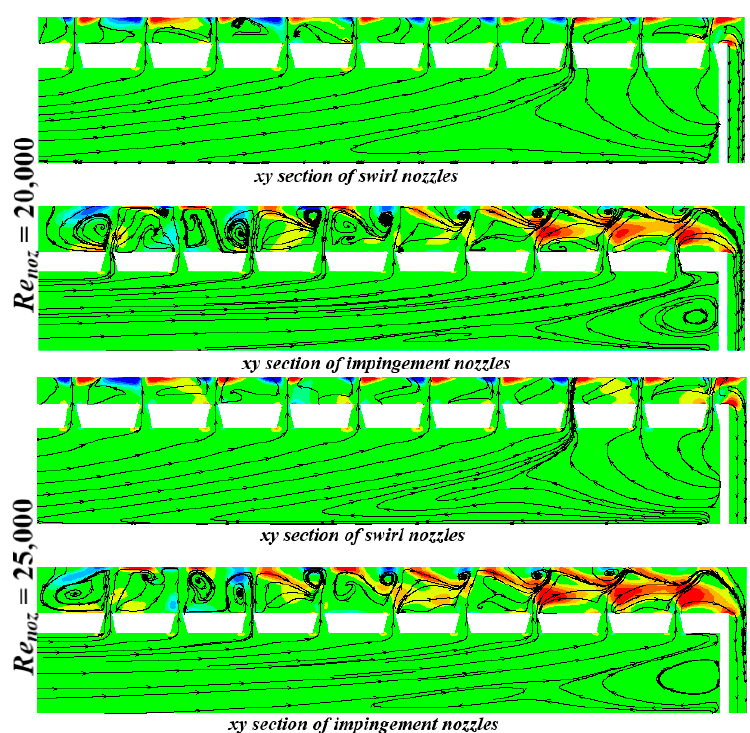
Figure 10. Axial velocity contours with streamlines of the compound cooling unit at different xy sections.